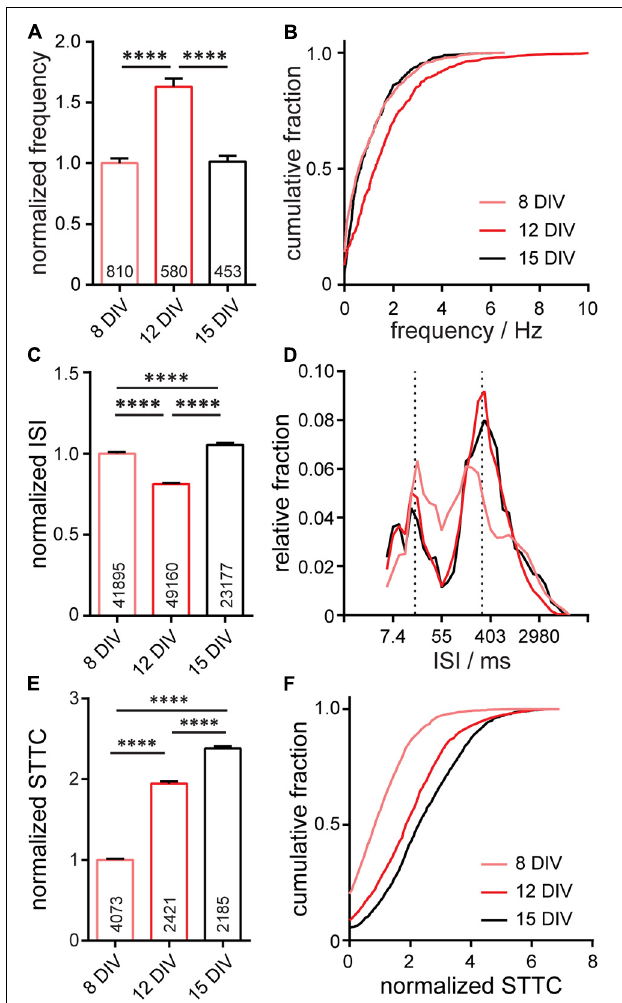
FIGURE 3 | Characterization of neuronal activity in 650 × 120 µ m microisland culture. Analyses of action potential frequency (A,B) , inter-spike interval, ISI, (C,D) , or spike timing tiling coefficient, STTC, (E,F) over developmental stages (8, 12, and 15 days in vitro ; DIV) are summarized as a bar graph (A,C,E) and as a cumulative frequency plot (B,F) , or histogram (D) . Values on bar graphs indicate numbers of neurons (A) , pairs of spikes (C) , or pairs of neurons (E) analyzed for each condition. Data represent 4 biological replicates. Frequency, ISI, and STTC values are normalized to the 8 DIV value per biological replicate. Statistical tests are Kruskal-Wallis ANOVAs with multiple comparison tests to all groups. ∗∗∗∗ p < 0.0001.